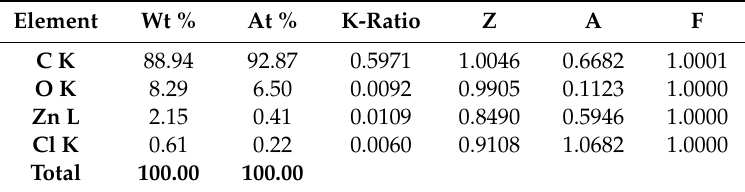
Table 2. Elemental composition of EM2 + ZnCl 2